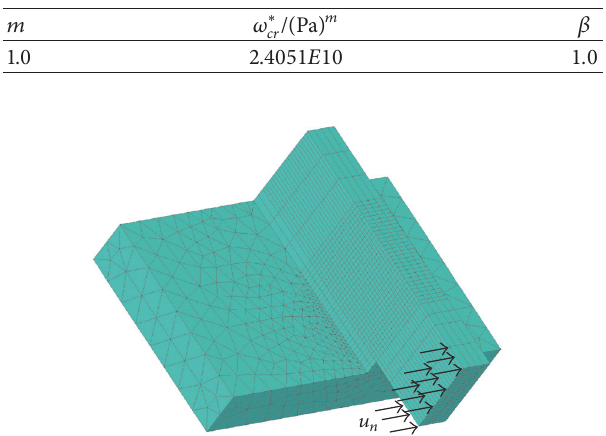
Table2:Materialpropertiesindamageevolutionequationformate- rial 5A06 with 𝐾 𝑇 = 1 .